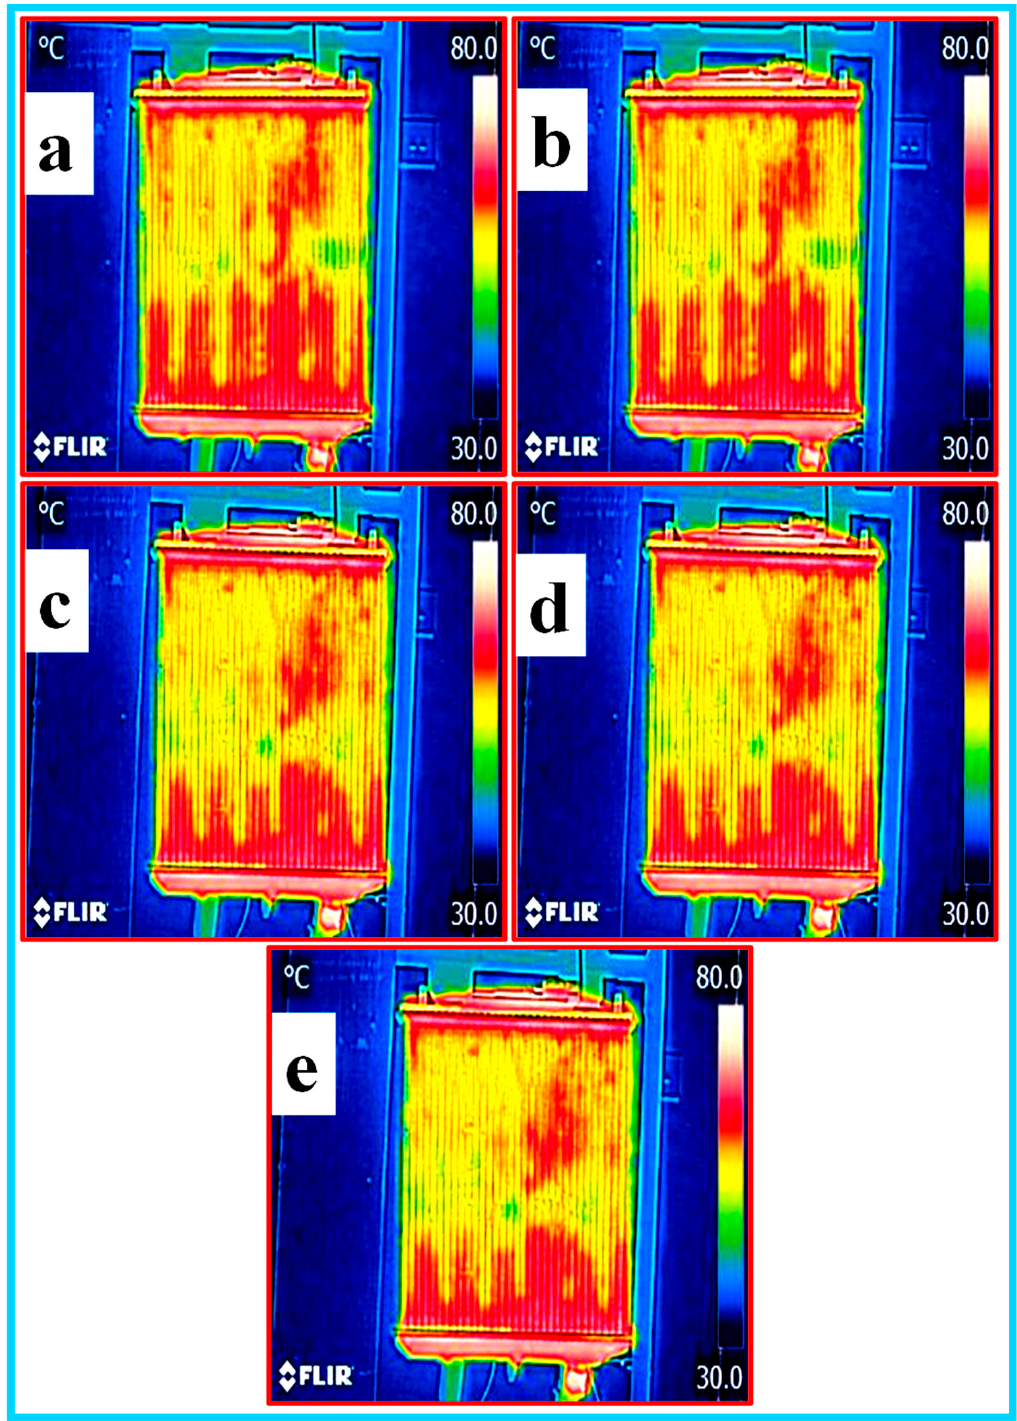
Figure 15. Thermal imaging of the CNC with a 0.5% volume concentration in the radiator ( a – e ). (d) Temperature at radiator fin: as per the above discussion, 0.5% volume concentration Al 2 O 3 /CNC was found to be better than the CNC and EG–W in terms of thermal heat properties,